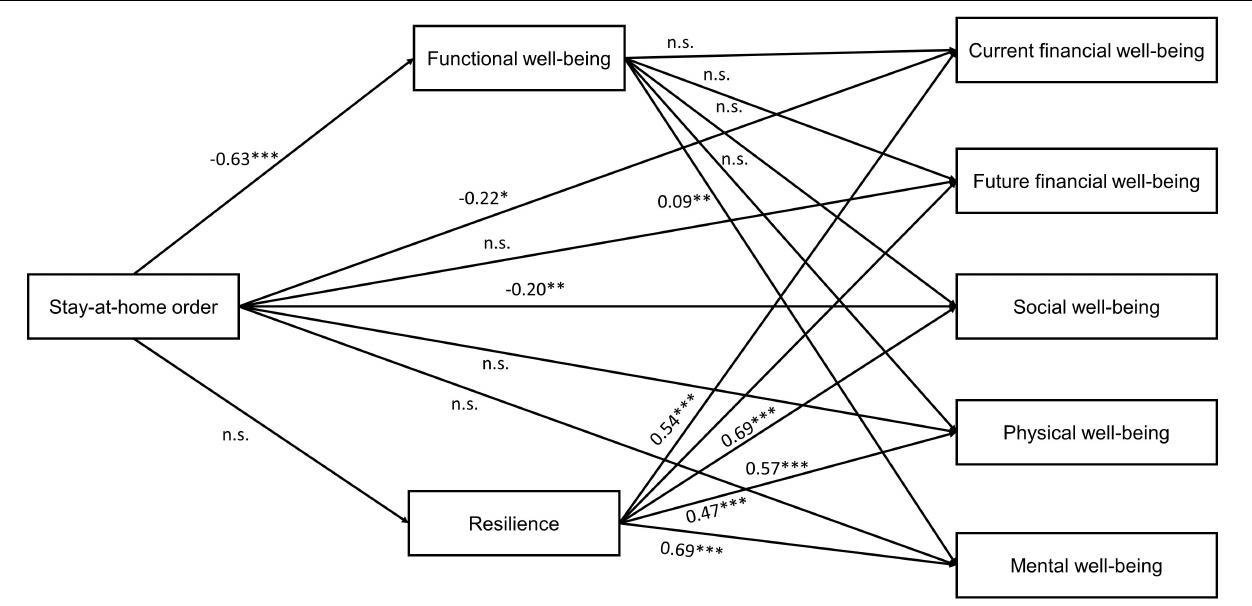
FIGURE 2 | Path coefficients for hypothesized